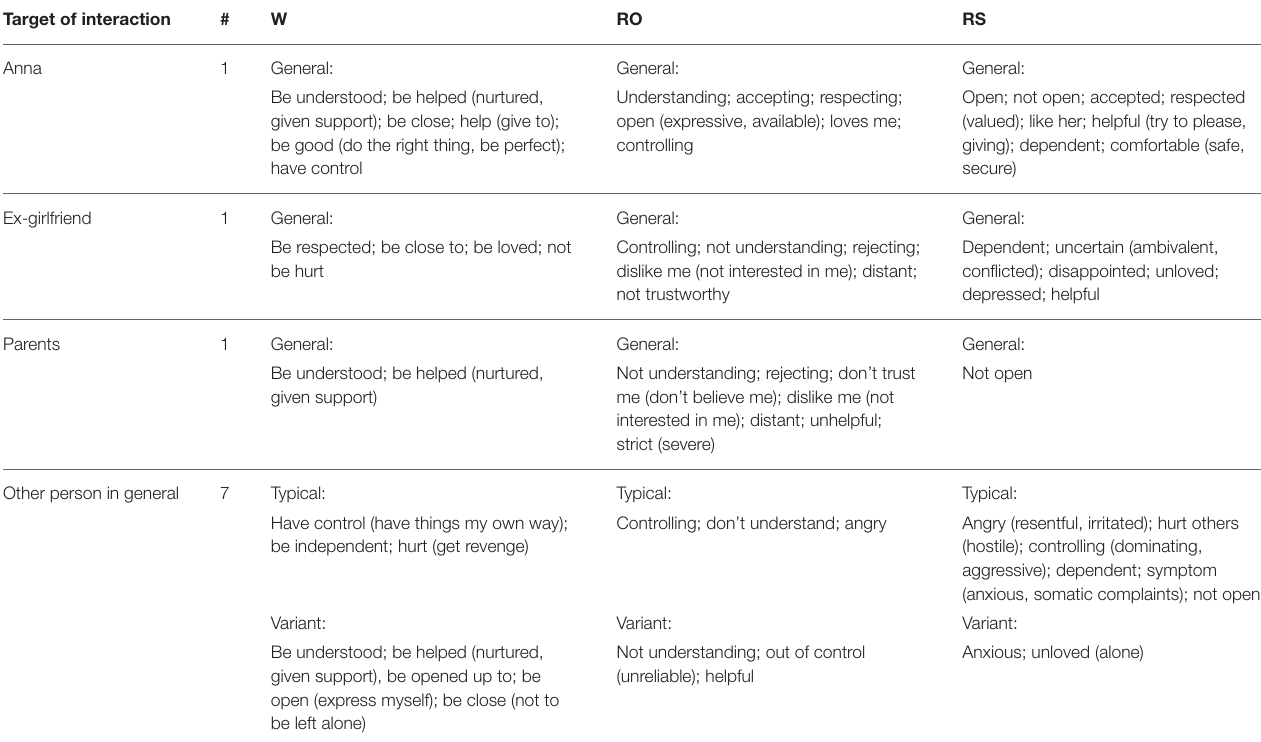
TABLE 2 | Patient’s wishes (W), responses of other (RO), and responses of self (RS) in sessions 5–7. Target of